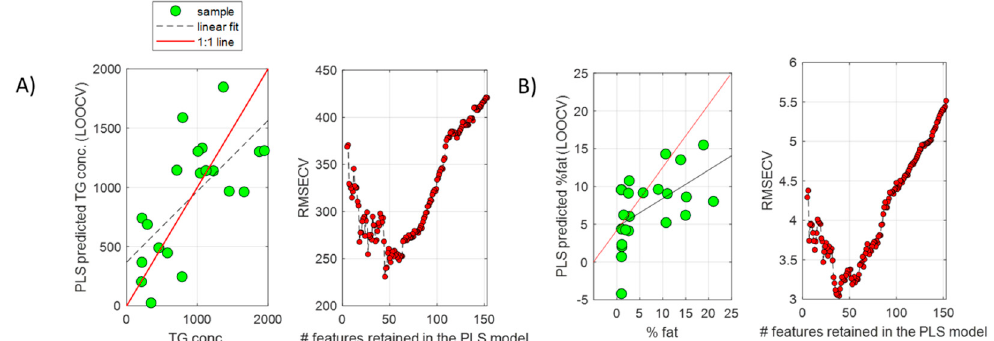
Figure 2. PLS regression of liver and serum miRNA profiles. PLS predicted TG concentrations (µg TG/mg protein) (( A ), left) or % fat (( B ), left) by LOOCV, and evolution of the RMSECV as a function of the number of retained features included in the PLS models during the recursive feature elimination analysis for model optimization in liver tissue (( A ), right) or serum (( B ), right) samples.